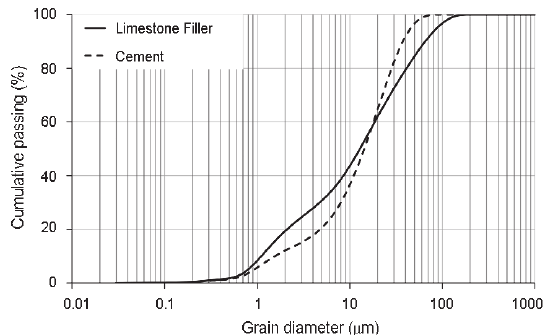
Fig. 1. Grain size distributions of cement and limestone